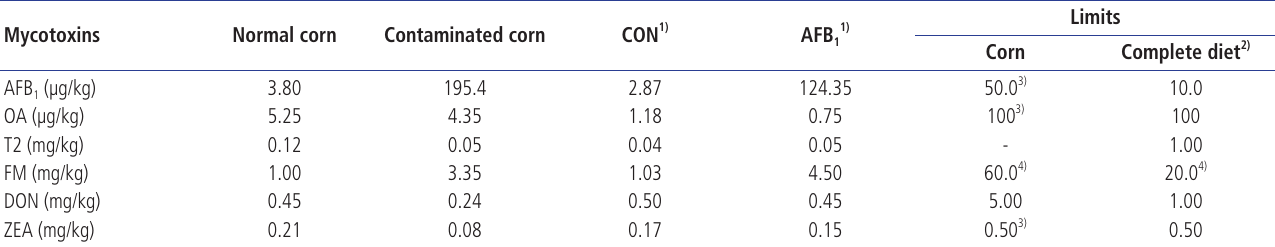
Table 3. The concentration of mycotoxins in corn and diets Mycotoxins